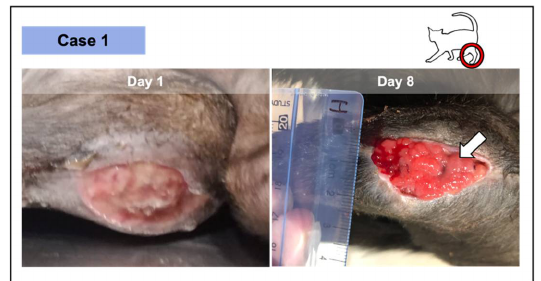
Figure 3. Wound from case 1, where 2 PRF grafts were implemented—at the initial appointment and at day 8. The lesion was the result of the dehiscence of the surgical repair of a metaphysis fracture at the level of the distal left femur, in this 9-month-old short-hair cat. The significant granulation tissue was verified after 8 days in an initial pale and devitalized wound (day 1). After 2 PRF treatments, epithelial tissue was perceived (white arrow) as a thin whitish layer above the vascularized